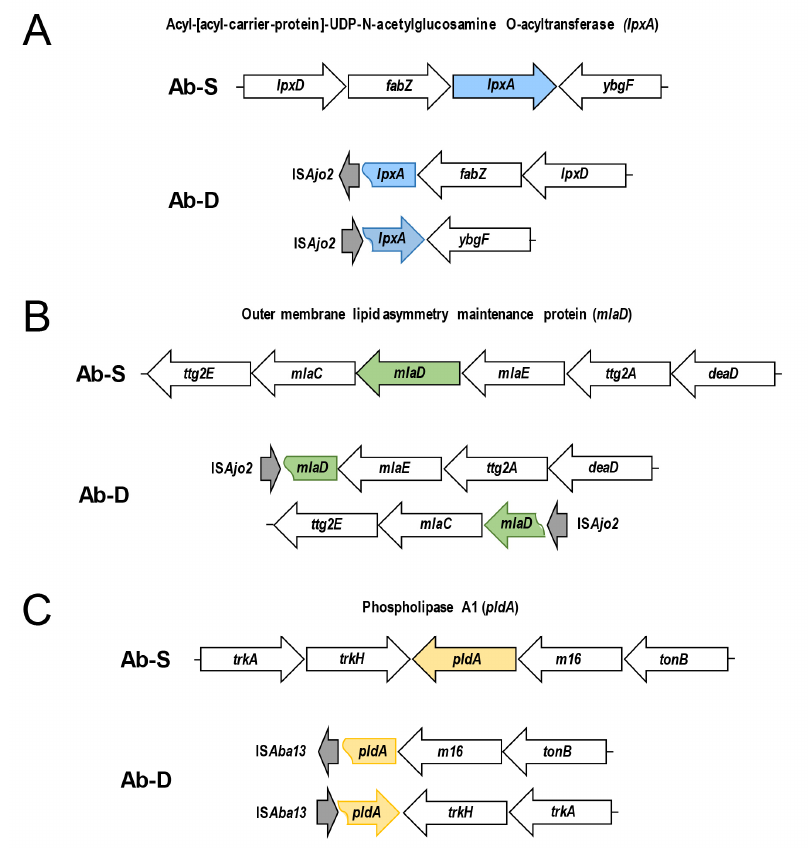
Figure 4. Schematic representation of IS Ajo2 and IS Aba13 disrupting lpxA , mlaD , and pldA genes in colistin-dependent A. baumannii . The arrangement of the gene clusters is illustrated for colistin-susceptible (Ab-S) and colistin -dependent (Ab-D) A. baumannii . IS Ajo2 disrupting the lpxA gene ( A ) and mlaD gene ( B ); IS Aba13 disrupting pldA ( C ). Gene clusters in Ab-S (top) are compared with corresponding disrupted Ab-D clusters (bottom). The identified insertion sequences ISAjo2 and IS Aba13 are shown with gray arrows. Arrows designate transcription directions of